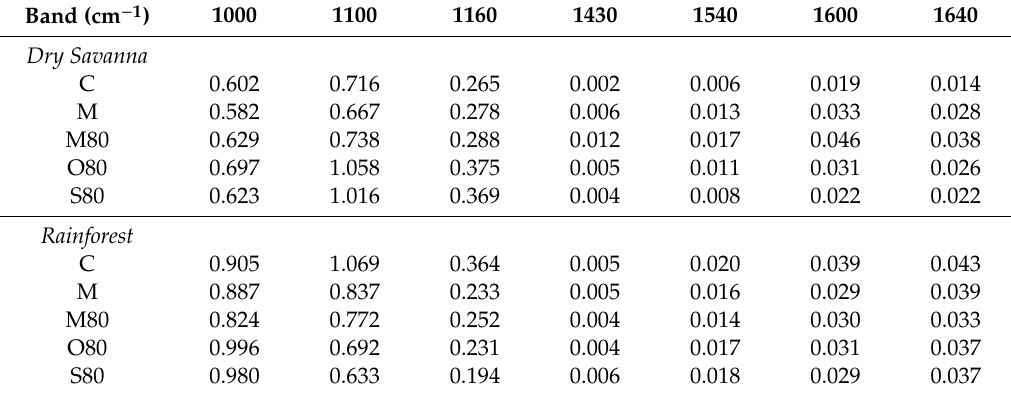
Table A2. The abundance of di ff erent C functional groups in the soil sample after harvest (AH) as estimated using the absorbance intensities of the ATR-FTIR